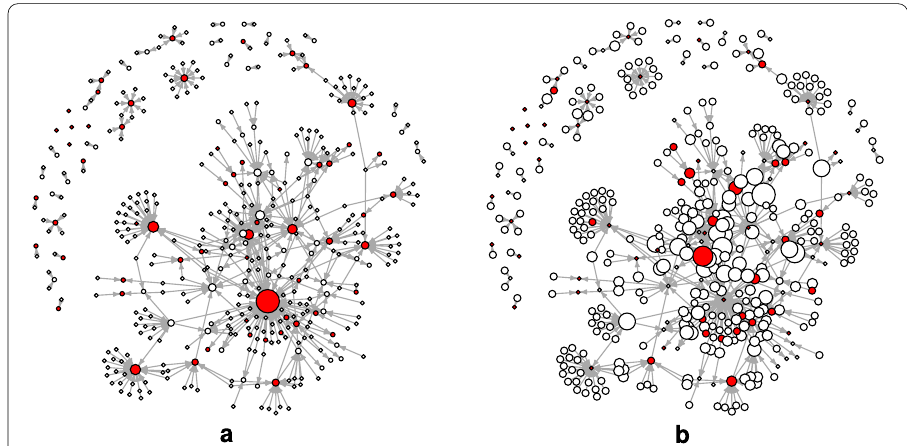
Parameter estimates that are statistically significant are shown in bold. In Models 3 and 4, self-edges (loops) are retained in the network and allowed in the model